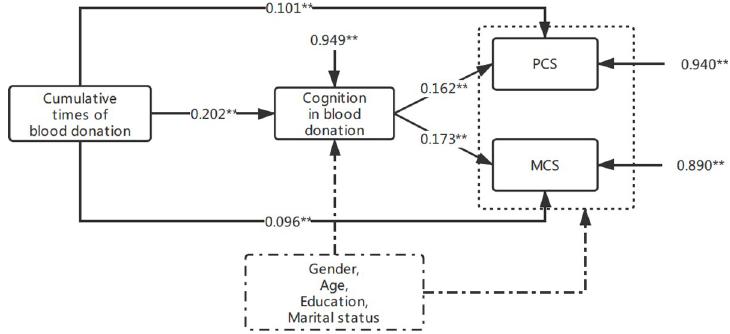
Fig 1. Path diagram for the mediating effect of cognition in blood donation. Values represent standardized path coefficients by a path analysis using Mplus 8.0 employing the S-B robust estimation method. Path coefficients are presented. P value for the path: �� p < 0.01 (both sides).